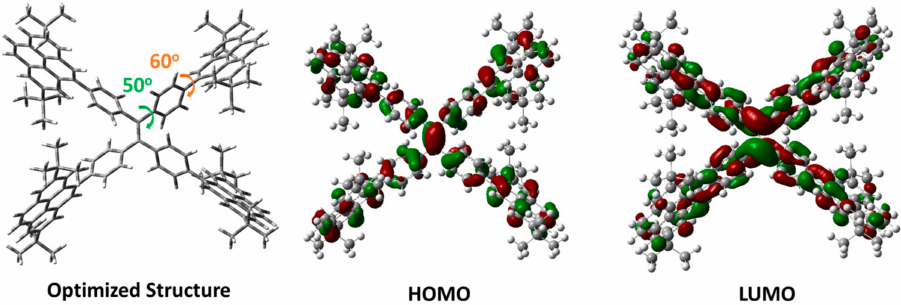
Figure 2. Optimized molecular structure and calculated molecular orbital amplitude plots of HOMO and LUMO levels of